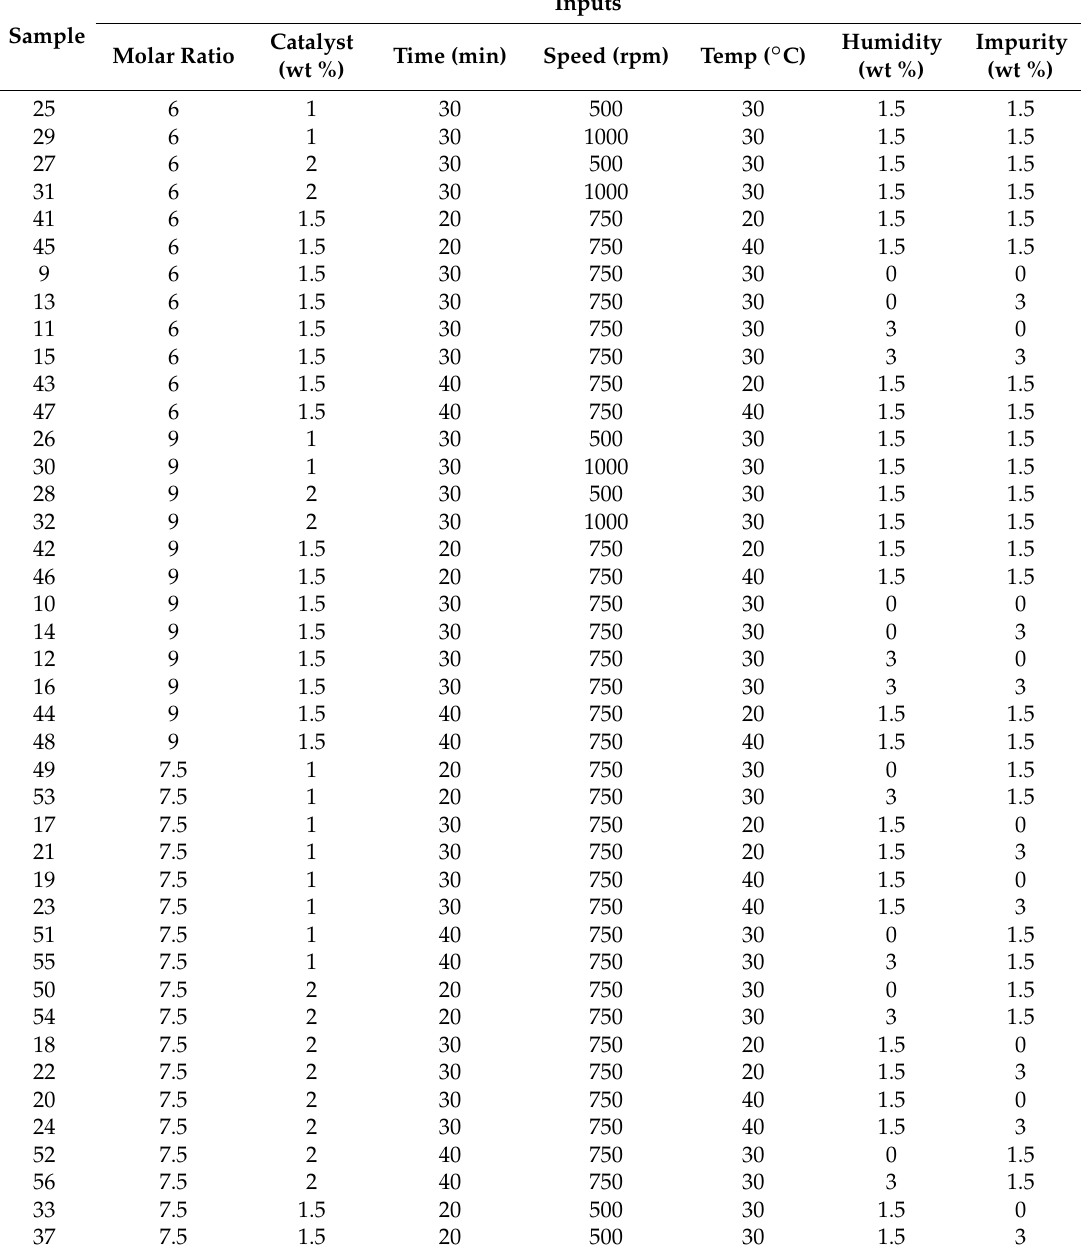
Table 2. Design matrix for transesterification